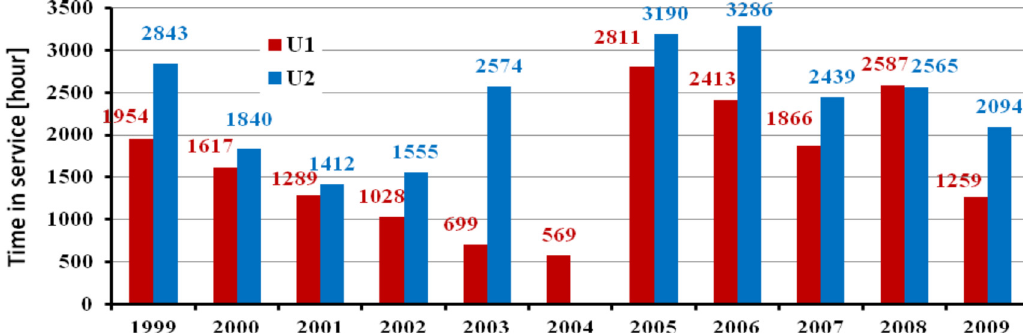
Fig. 2. Number of hours in service of the old Francis turbines units: U1 (red) and U2